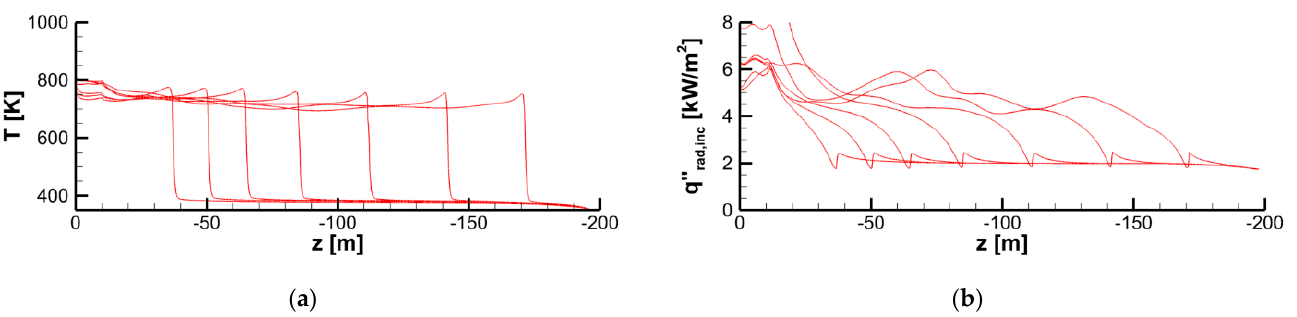
Figure 25. Distributions of temperature ( a ) and incident radiation ( b ) at the specimen surface along the vertical centerline at time instants of 20, 40, 60, 80, 100, 120, and 140 s. In this scenario, the flame is optically thin and almost transparent for thermal